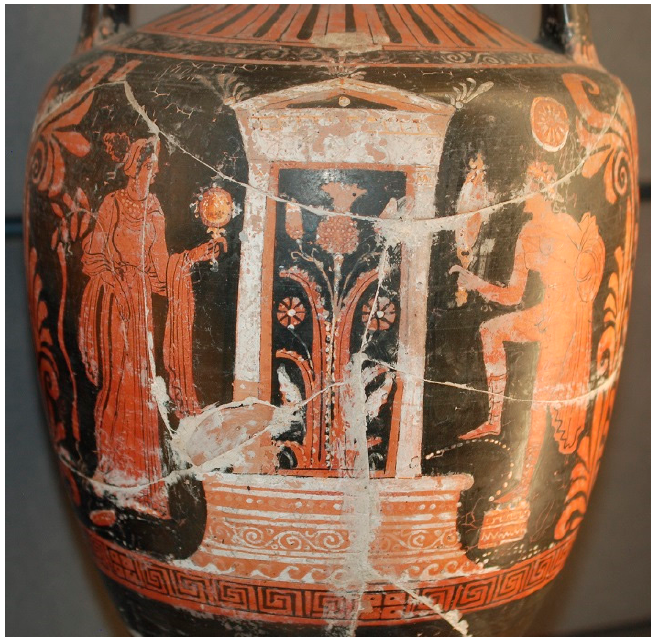
Figure 18. Bologna, Museo Civico Archeologico G 327 Apulian amphora, Painter of Würzburg 853, ca. 340–330 B.C. Naiskos containing vegetation and thistle flower with woman holding mirror and branch with suspended fillet on left and youth holding handled patera on right. Author’s photo.